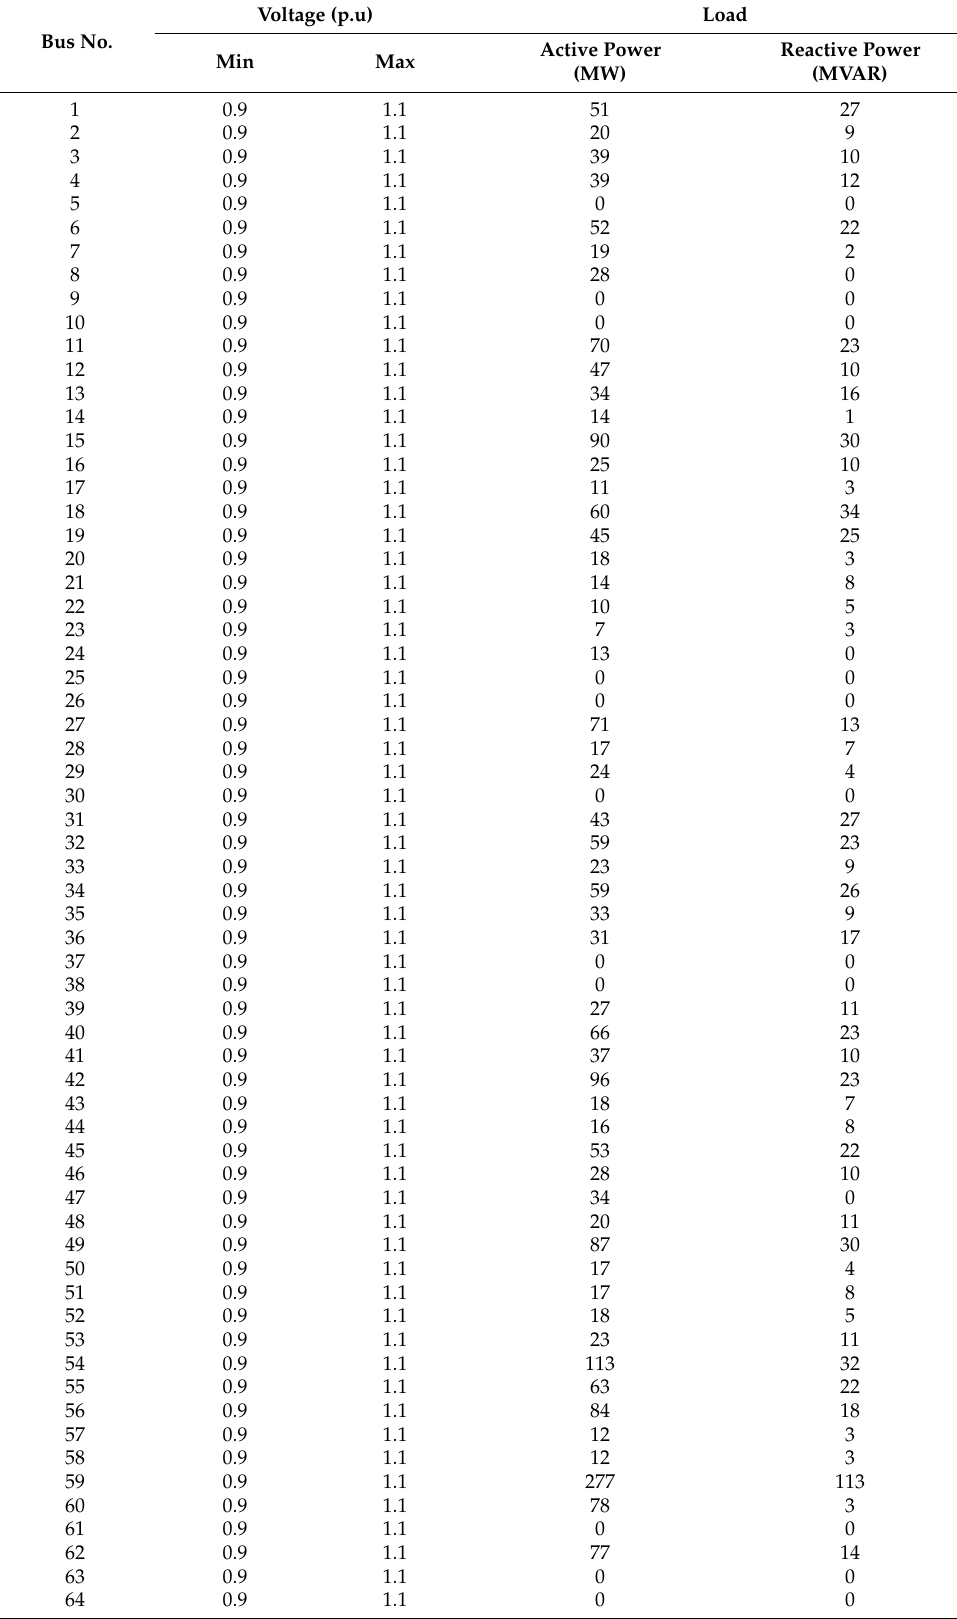
Table A2. Voltage constraints, and load data of each bus for the 118-bus system. Bus